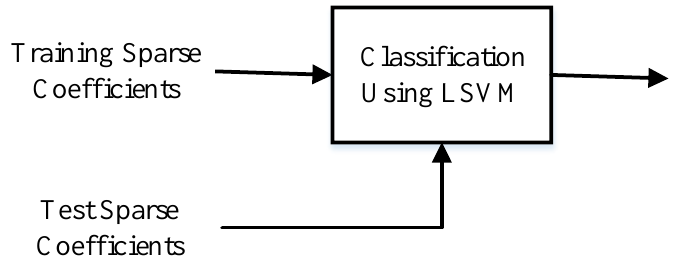
Figure 3. ECG classification using